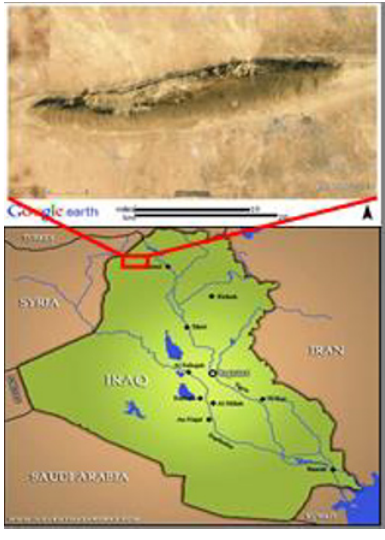
Figure 1. Sinjar area.